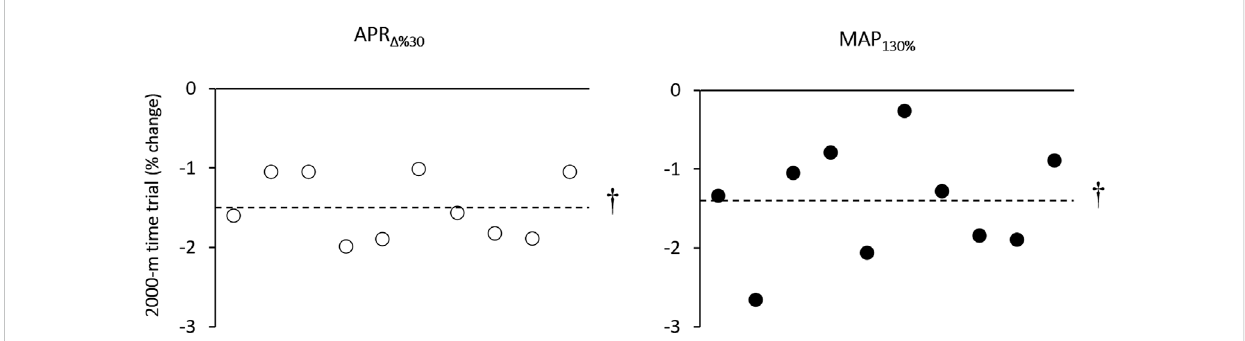
FIGURE 5 Individual changes in 2000-m rowing ergometer time trial after the training period. † Denotes Signi fi cantly different versus pre-training ( p ≤